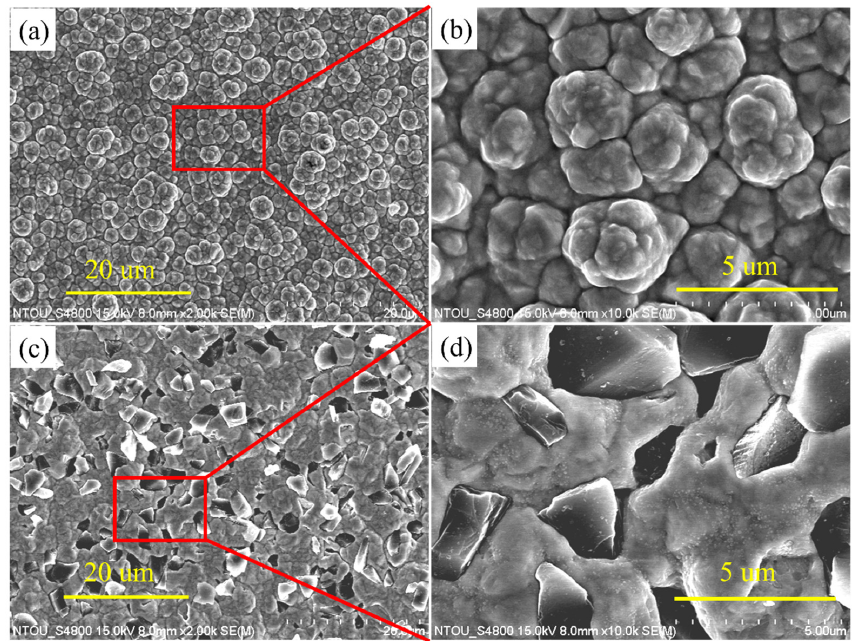
Figure 2. The surface morphology by SEM. ( a ) Ni coating, ( b ) the magnified morphology of ( a ), ( c ) Ni–diamond coating, ( d ) the magnified morphology of ( c ).